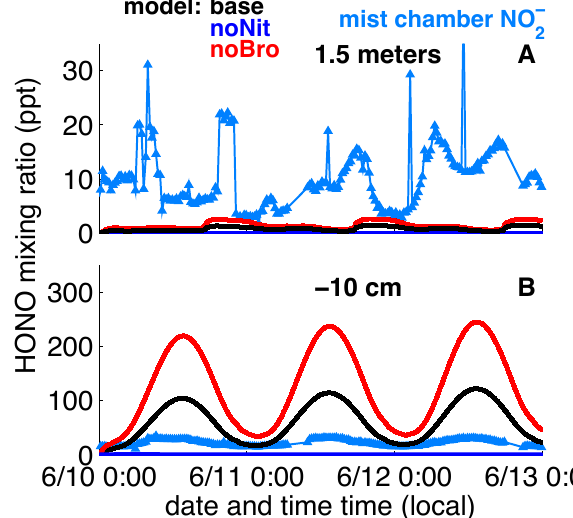
Fig. 4. Model predicted HONO for a three day model run (10– 13 June 2008) for the base, noNit, and noBro cases compared to mistchamber measurements of soluble nitrite with one inlet 1.5m above the snow surface and one inlet 10cm below the snow surface, sampling interstitial